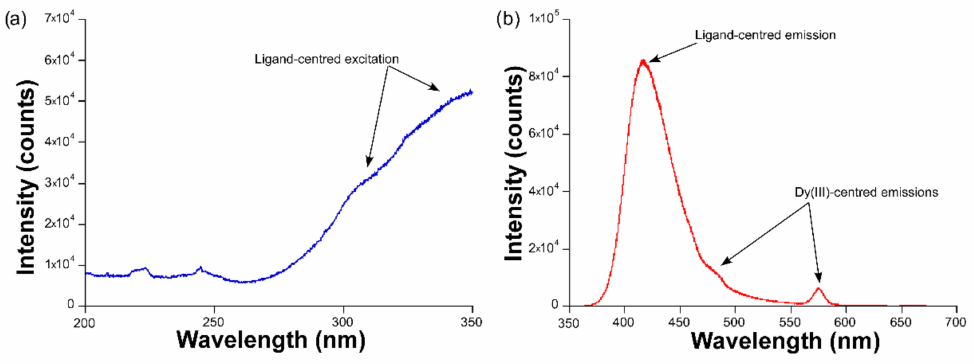
Figure 3. The ( a ) excitation ( λ em = 576 nm) and ( b ) emission ( λ ex = 325 nm) spectra of compound 1 , acquired at room